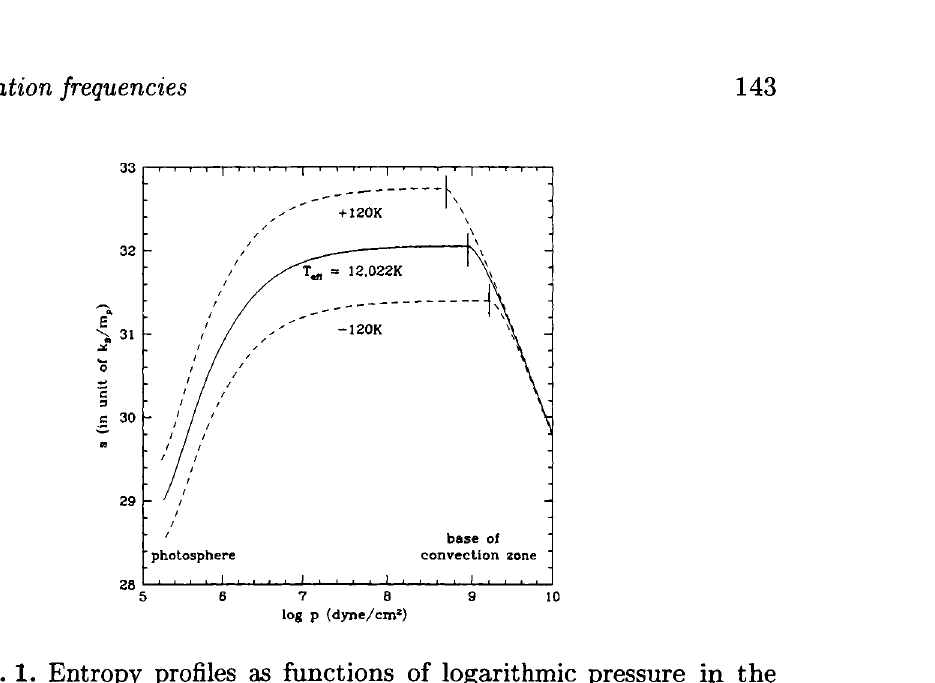
Fig. 1. Entropy profiles as functions of logarithmic pressure in the upper atmosphere of three DA white dwarf models adjacent in their T The bottom of the convection zone (marked with short vertical bars) moves around by a pressure scale-height when the surface flux varies by ~